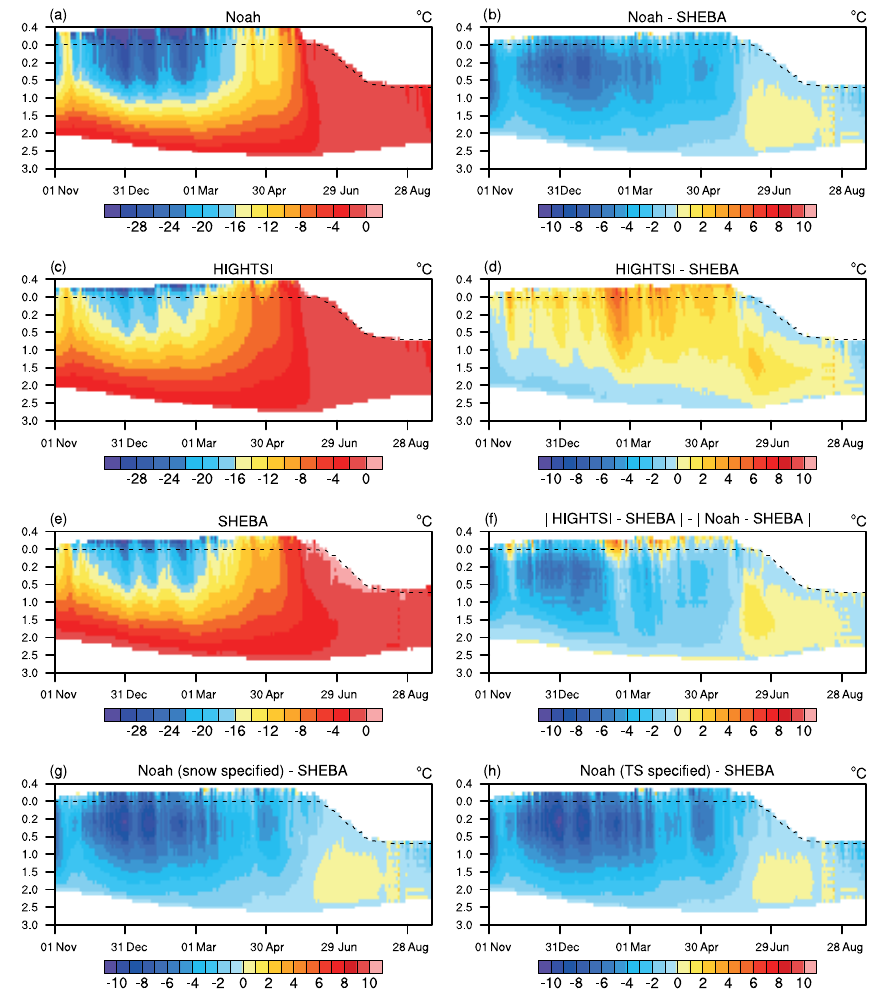
Figure 2. The evolution of sea ice temperature: results from (a) Noah, (c) HIGHTSI and (e) SHEBA observation; bias of (b) Noah, (d) HIGH- TSI, (g) Noah with specified snow depth on sea ice and (h) Noah with specified snow depth and surface temperature on sea ice; and (f) the difference between the absolute bias of HIGHTSI and